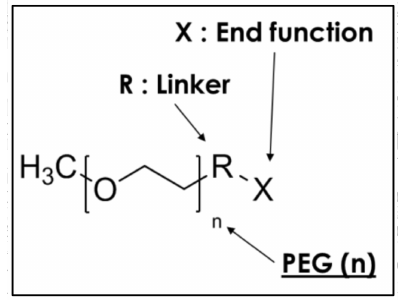
Figure 2. Structure of PEG-based additives. Table 1. Composition of hydrophilic additives of poly(dimethyl siloxane) (PDMS)